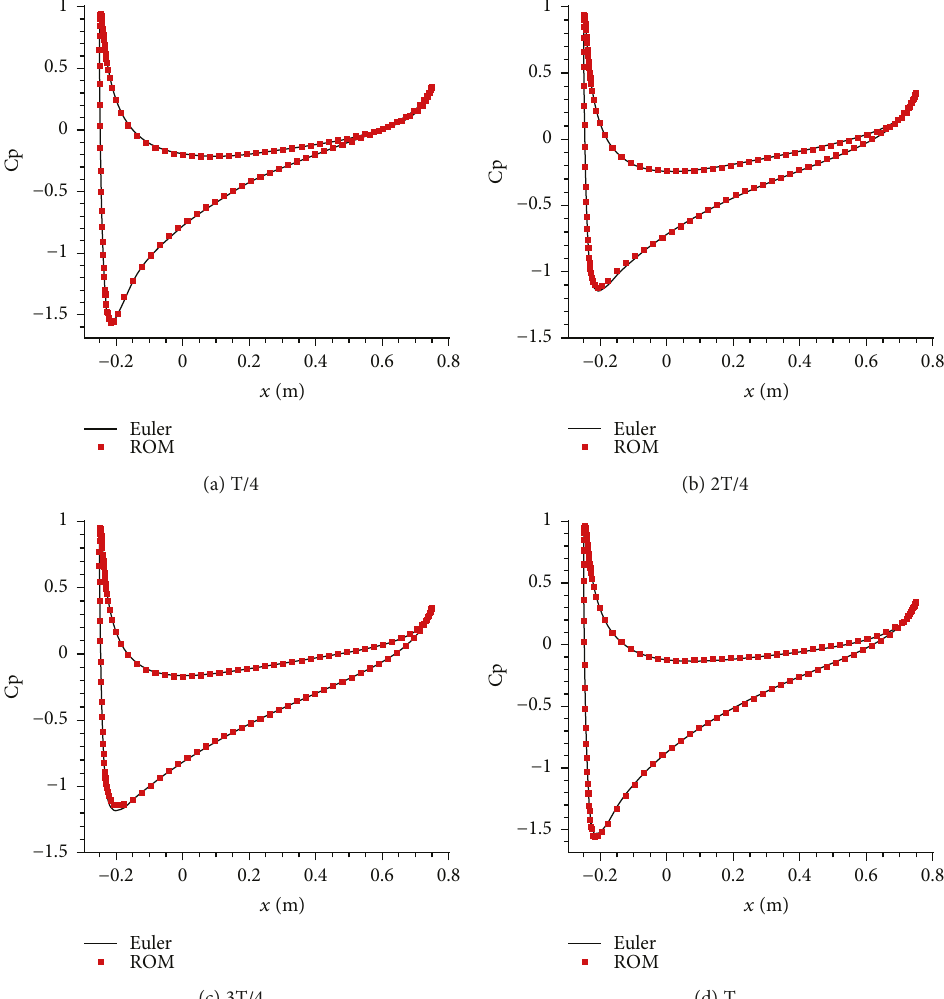
Figure 8: Pressure distribution predicted by the Euler and ROM at (a), (b), (c), and (d) when f = 40 Hz.